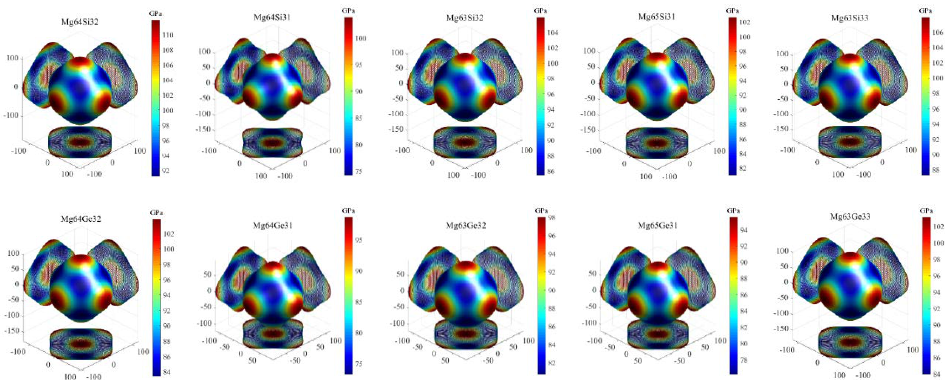
(GPa) of Mg 2 X (X=Si, Ge) Intermetallics in the 1×1×2 𝐸𝐸